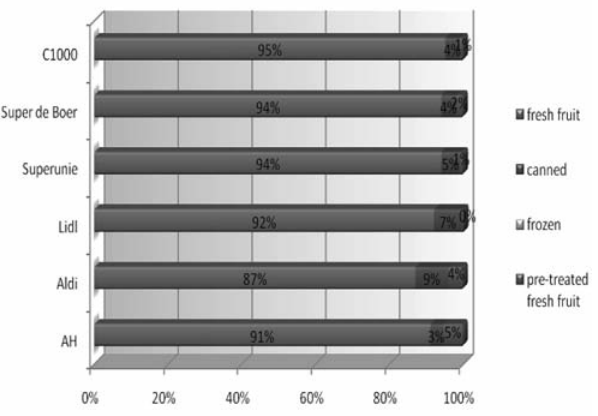
Figure 7. Fruit in supermarket chains in 2010 (value) Source: PT / Nielsen